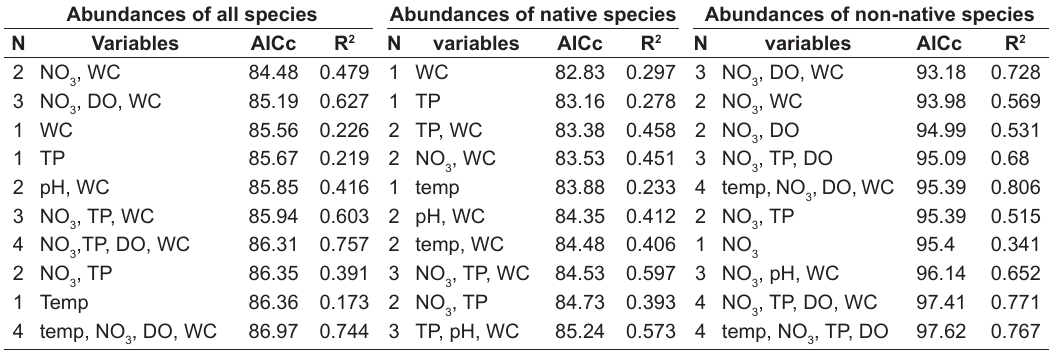
Table 5. First 10 best overall models found for fish assemblages of Sauce Grande River using the AICc criterion. Abundances of all